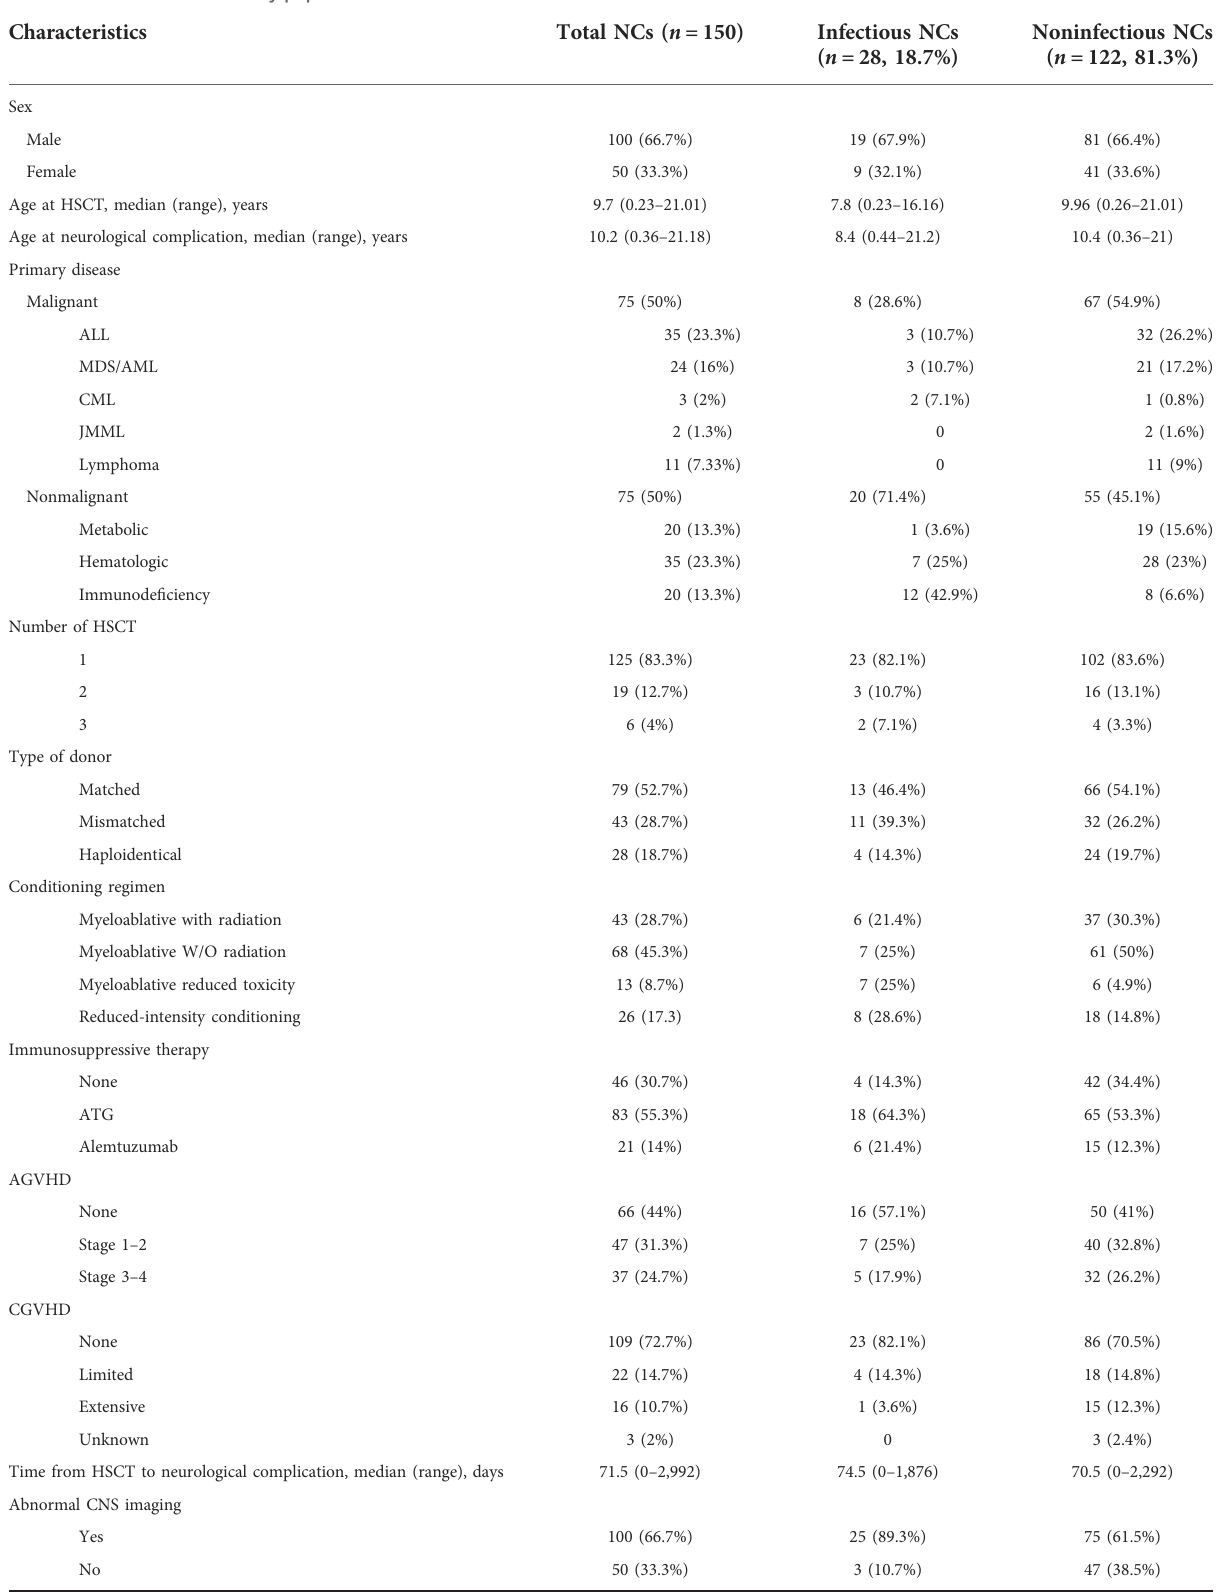
TABLE 1 Characteristics of study